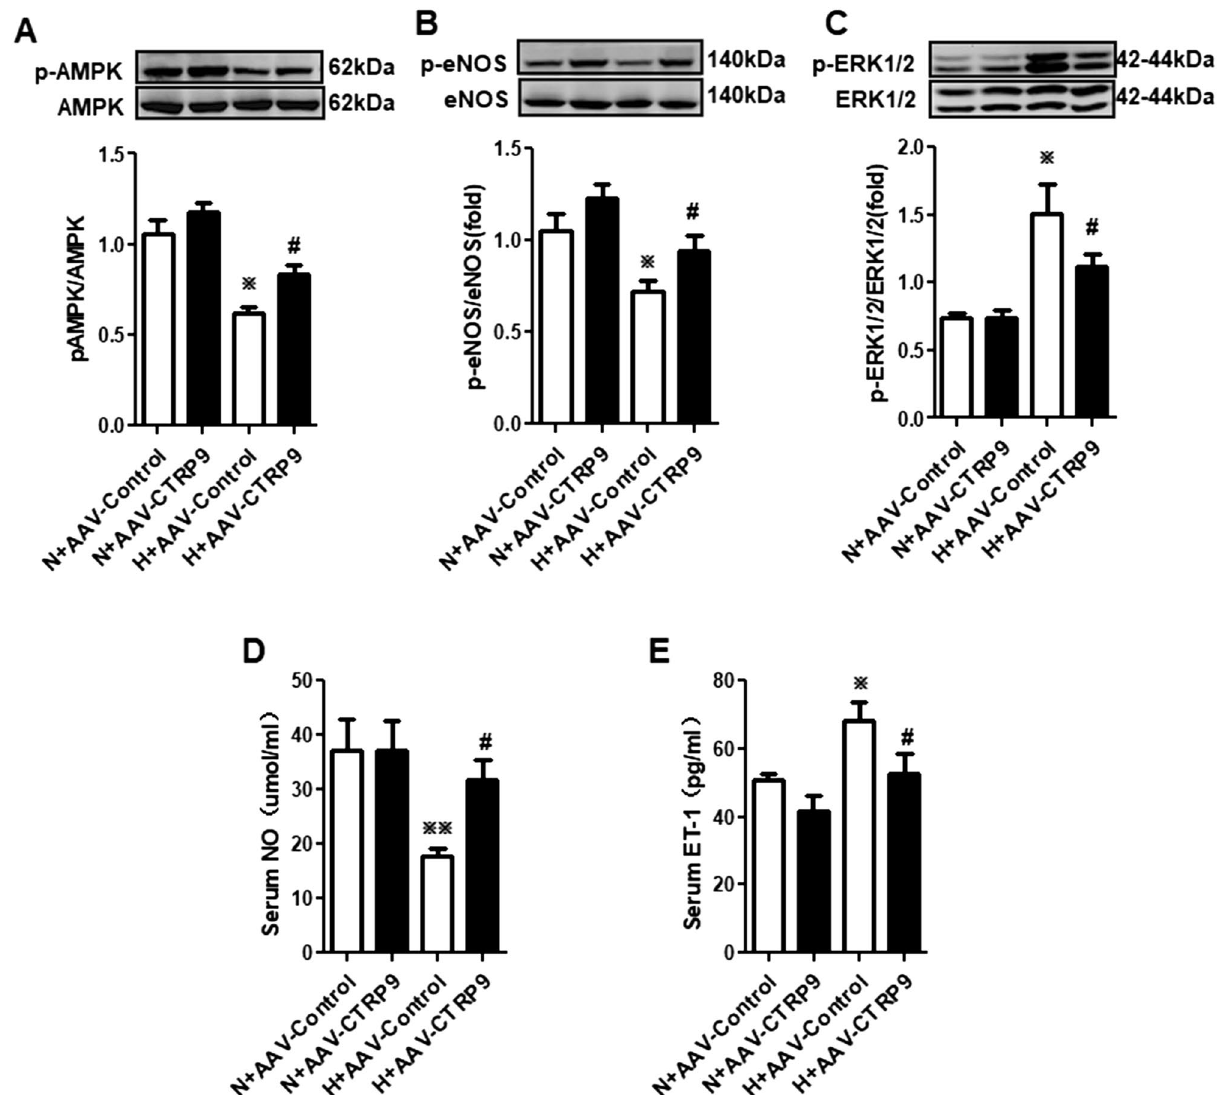
Figure 4. CTRP9 overexpression promoted phosphorylation of AMPK and eNOS and decreased ERK1/2 phosphorylation in isolated endothelial cells from the lungs of HPH rats. ( A – C ) Western blotting of expression of AMPK and p-AMPK ( A , n = 3; blots are cropped from different gels), eNOS and p-eNOS ( B , n = 3; blots are cropped from different gels), ERK1/2 and p-ERK1/2 ( C , n = 3; blots are cropped from different gels) in endothelial cells from lungs of HPH rats using GAPDH as an internal control. The ratio of p-AMPK to AMPK, p-eNOS to eNOS, and p-ERK1/2 to ERK1/2 was calculated. ( D , E ) Levels of NO (n N+AAV-Control = 3, n N+AAV-CTRP9 = 3, n H+AAV-Control = 4, n H+AAV-CTRP9 = 3) and ET-1 (n N+AAV-Control = 5, n N+AAV-CTRP9 = 5, n H+AAV-Control = 4, n H+AAV-CTRP9 = 5) in rat serum were measured. Data are the mean ± SEM. P < 0.05, ※ ※※ maintained at normoxia for 4 weeks, N + AAV-CTRP9 transfection of AAV-CTRP9 vectors maintained at normoxia for 4 weeks, H + AAV-Control transfection of AAV-Control vectors maintained at hypoxia for 4 weeks, H + AAV-CTRP9 transfection of AAV-CTRP9 vectors maintained at hypoxia for 4